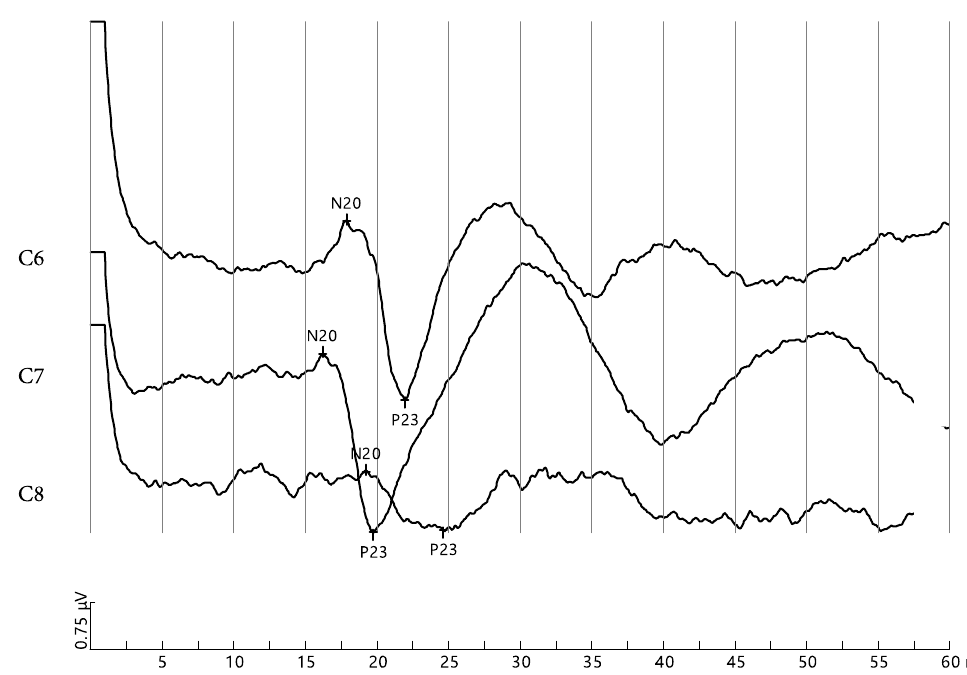
Figure 5. Short latency somatosensory-evoked potential of a normal head posture (NHP) participant before prolonged slouched sitting for C6, C7 and C8. The amplitudes measured between N20 and P23 are: 2.45 μV, 2.8 μV, and 1.14 μV, respectively.